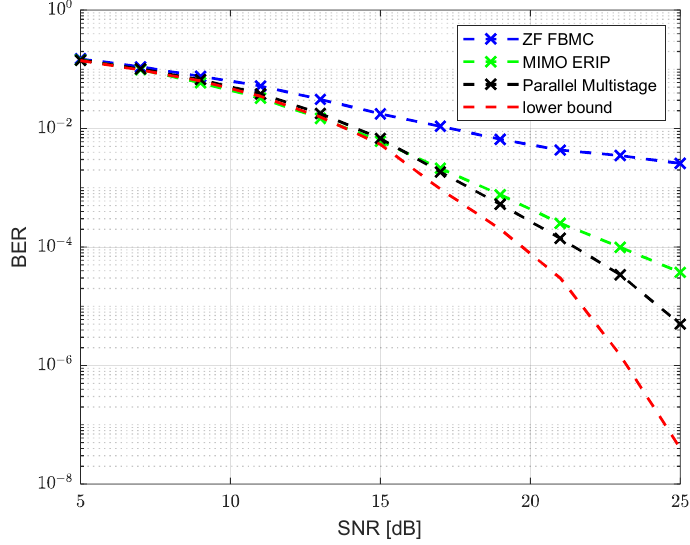
Figure 9. Uncoded BER performance versus SNR for HFLQ channel model.